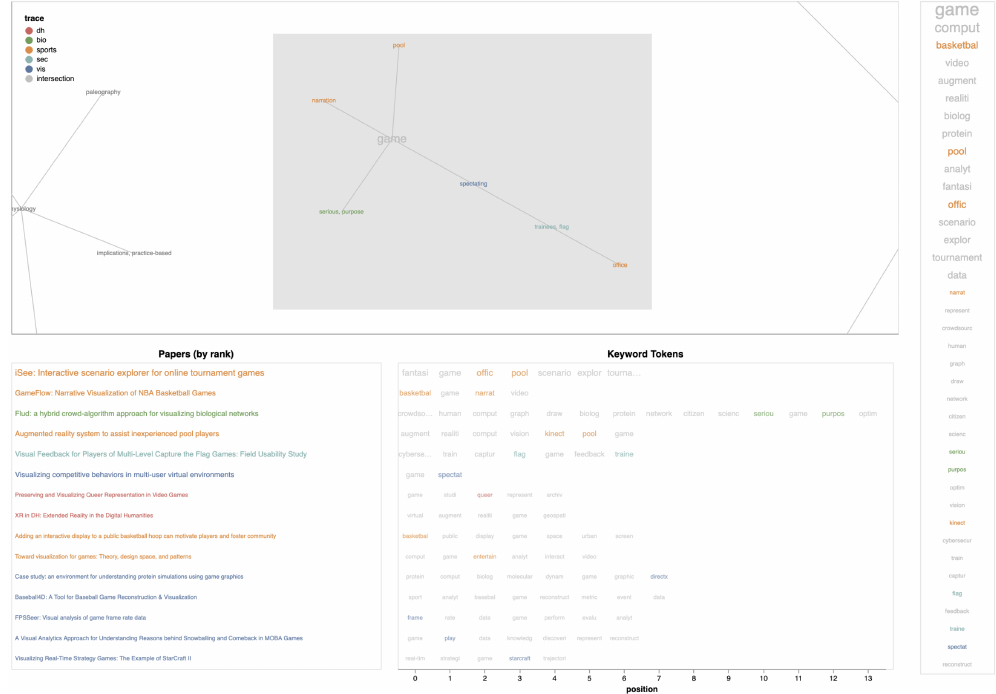
Figure 10. Close view of component #2 in GlassViz’s main view. We encourage readers to download the high-resolution images companion to this paper which can be zoomed and explored to get a better understanding of how GlassViz